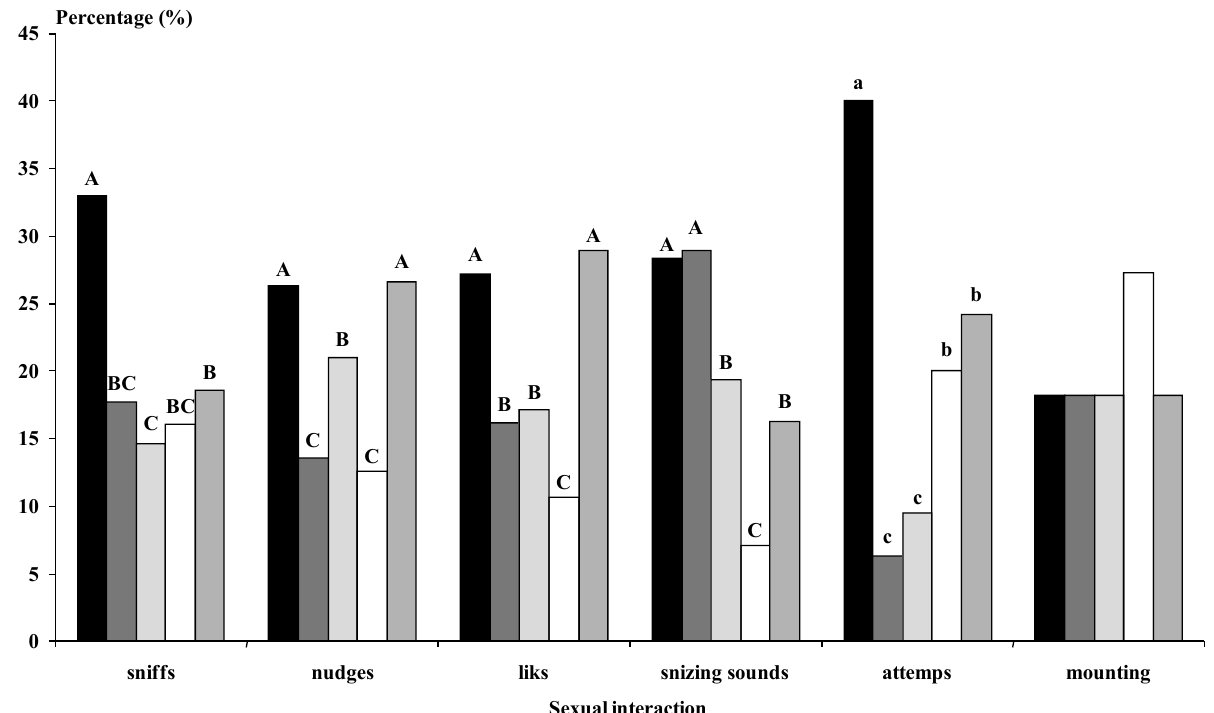
Figure 6. (Experiment 2). Types of sexual advances (%) experienced by females submitted to the male effect using photoperiod-treated males, i.e., long days for three months between November and February (Photo, ); males submitted to the same photoperiod treatment and a GnRH agonist at the onset of the photoperiod treatment (Photo-Ago Long, ); males submitted to the same pho- toperiod treatment and a GnRH agonist at the end of the photoperiod treatment (Photo-Ago Short, ); males subjected to the natural photoperiod (Natural, ) and males subjected to the natural photoperiod and a GnRH agonist at the same time as the Photo-Ago Short (Natural-Ago Short, ). Different letters in the same sexual advance differ significantly. Lower case (a, b, c) indicates dif- ferences p < 0.05 in the whole groups and capital letters (A, B, C) indicate differences p < 0.01 in the whole groups. Sniffs (when the buck sniffed the anogenital area of the doe). Nudges (when the buck kicked the doe) ; Licks (when the buck licked the flanks of the doe) ; Sneezing sounds (sounds emitted by the bucks) ; Mounting attempts (when the buck attempted to mount the doe without intromission) ; Mounts (when the bucks mounted the doe with intromission).